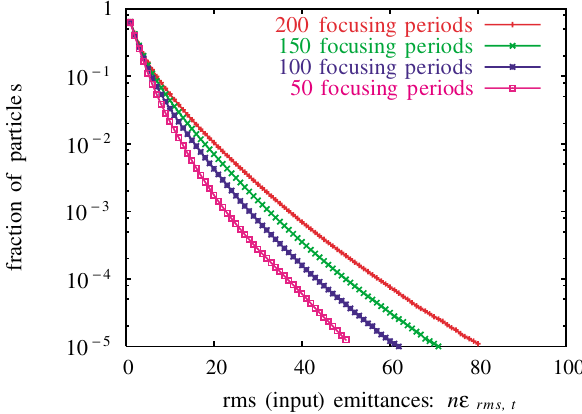
FIG. 12. (Color) Averaged fraction of particles exceeding n" for transport channels of different length (100 focusing rms ;t periods correspond to (cid:12) 10 : 7 zero-current betatron periods), 6D Gauss with 1% (rms) quadrupole gradient errors, 500 simulations, normalized to transverse input